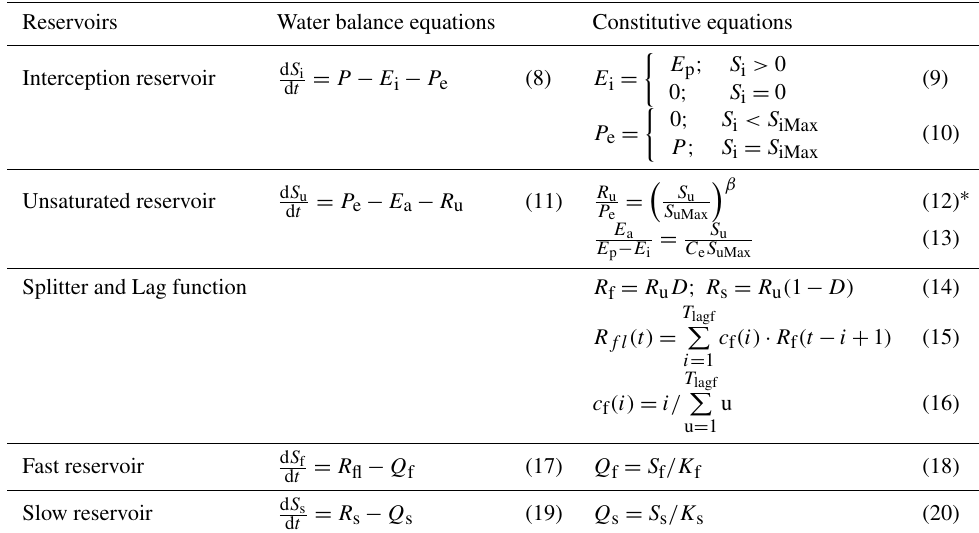
∗ S uMax is a parameter in HBV, TOPMODEL, and the HSC model, but the HSC-MCT model does not have S uMax as a free parameter; ∗∗ β is a parameter in the HBV model, but not in the TOPMODEL, HSC, and HSC-MCT models. Table 2. The water balance and constitutive equations used in models. (Eq. (12) ∗ is used in the HBV model, but is not used in the TOP- MODEL, HSC, and HSC-MCT